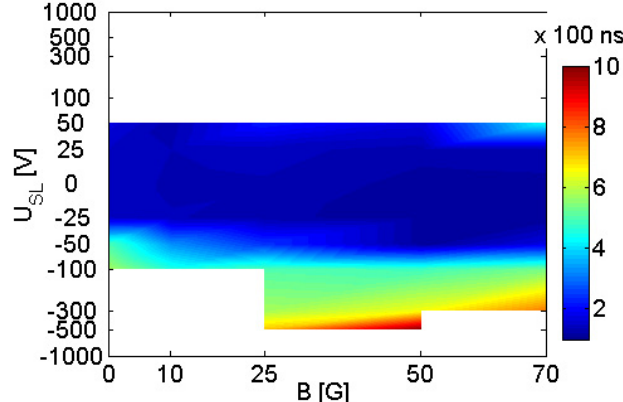
FIG. 12. (Color) Electron cloud buildup time measured with pickup #2 for the second last turn. The positions in the parameter space where the EC did not reach saturation are left blank in the plot. With magnetic field the buildup time shortens a bit, while it increases appreciably for negative clearing voltages.